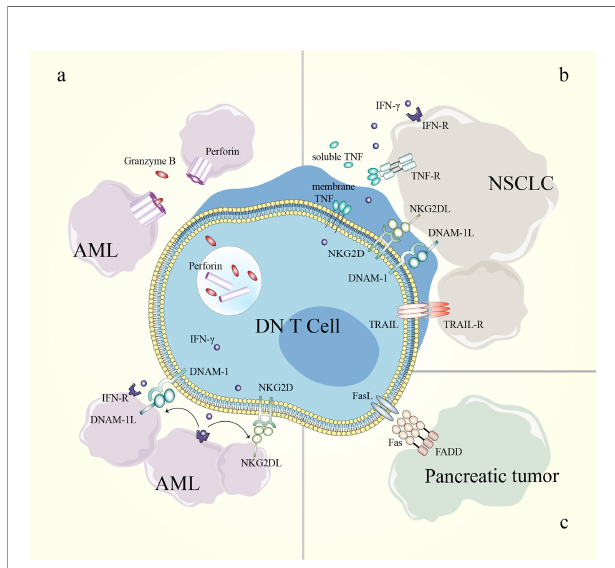
FIGURE 4 | Mechanisms of DN T cells in cancer treatment. (A) The killing effect of DN T cells toward AML cells can be perforin/granzyme B-dependent; IFN- g enhances the effect of NKG2D and DNAM-1 in the DN T cell-mediated inhibition of AML cells. (B) NKG2D, DNAM-1 and soluble TRAIL participate in DN T cell-mediated lysis of NSCLC cells. (C) DN T cells eliminate pancreatic tumor cells through the Fas/FasL pathway. AML, acute myeloid leukemia; DN, double-negative; DNAM-1, DNAX accessory molecule-1; DNAM-1L, DNAX accessory molecule-1 ligand; FADD, Fas-associating protein with a novel death domain; FasL, Fas ligand; IFN- g , interferon- g ; IFN-R, interferon receptor; NKG2D, natural-killer group 2, member D; NKG2DL, natural-killer group 2, member D ligand; NSCLC, non-small-cell lung cancer; TNF, tumor necrosis factor; TNF-R, tumor necrosis factor receptor; TRAIL, TNF-related apoptosis- inducing ligand; TRAIL-R, TNF-related apoptosis-inducing ligand